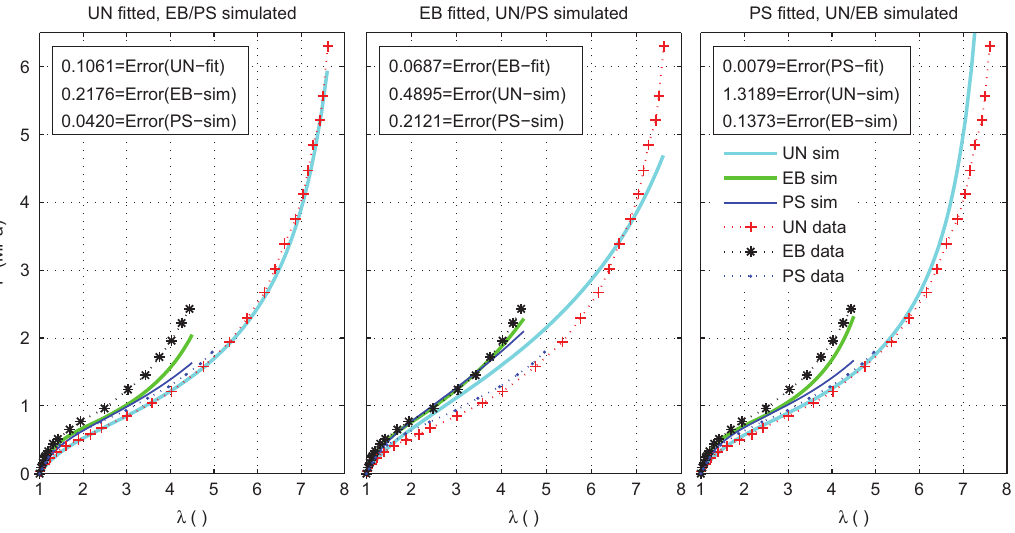
Figure 14 Performance of the Flory-Erman model modified by the 8-chain energy function on the Treloar data. The fitting quality is excellent, especially if compared with the similarly structured models, e.g., the original 8-chain model or the Gent